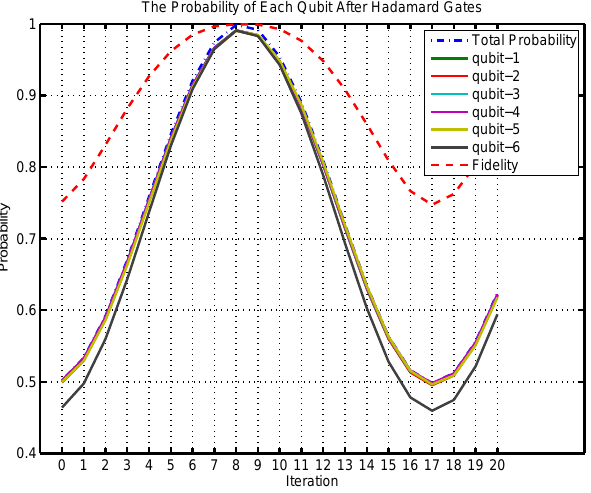
Figure 5: The probability to see a qubit in the first register in | 0 (cid:105) state after applying a Hadamard gate to the qubit and its comparison with the total probability and the fidelity given in Figure 4f. Note that the above separate curve is the fidelity. Since there are only small di ff erences between the probabilities on the individual qubits and the total probability, the curves for the probabilities mostly